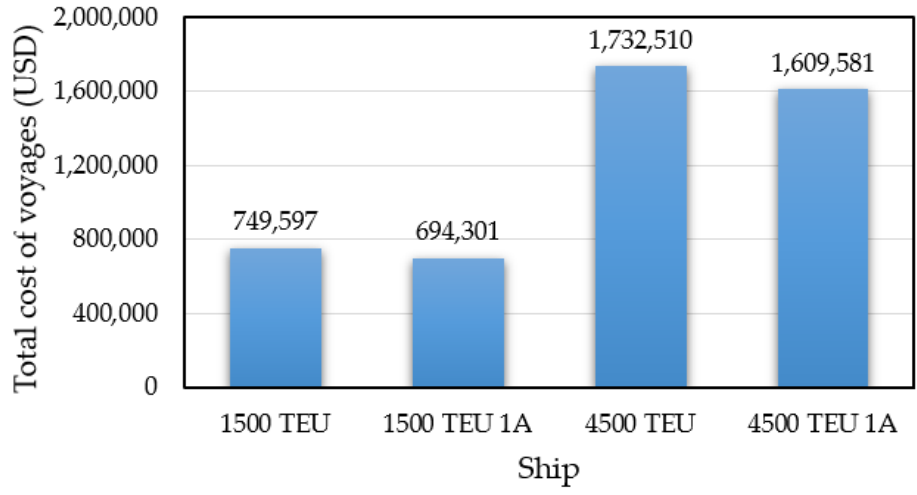
Figure 8. Total voyages cost for Americas sea route and the Northwest Passage.